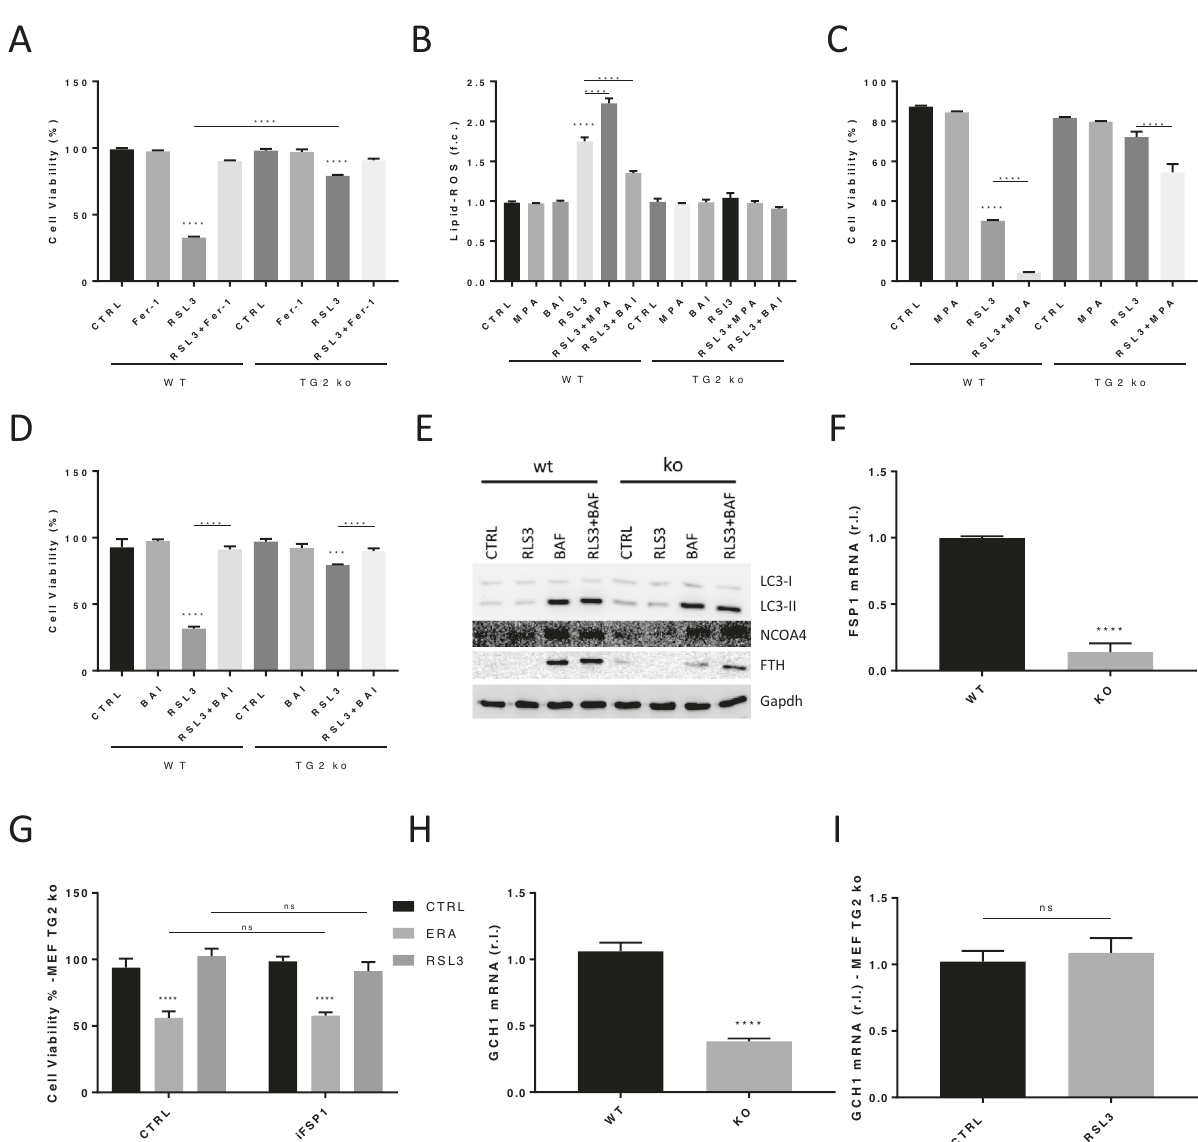
Fig. 1 TG2 ko MEFs are resistant to Ferroptosis. A MEF wt and TG2 ko were exposed to 20 nM RSL3 alone or in combination with Fer-1 (10 μ M) and cell viability was evaluated after 18 h, in cells stained with FDI/PI, by fl ow cytometry. B MEF wt and TG2 ko were treated as indicated and Lipid-ROS were evaluated after 8 h, by cyto fl uorimetric analysis of BODIPY C11 stained cells. C & D Cells were treated as indicated and cell viability was evaluated as in A. E MEF wt and TG2 ko were cultivated in complete medium ± BAF (5 nM) or exposed to RSL3 (20 nM) ± BAF and Autophagy was evaluated as LC3 conversion, while Ferritinophagy was evaluated by measuring the protein levels of FTH and NCOA4. F Basal expression of FSP1 was evaluated in wt and TG2 ko MEFs by qPCR. G Cell viability was evaluated as in B in TG2 ko MEF cells exposed 18 h to RSL3 (20 nM) alone or in combination with iFSP1 (6 μ M). H Basal expression of GCH1 was evaluated in both wt and TG2 ko MEFs by qPCR. I TG2 ko MEFs were treated or untreated with 20 nM RSL3 and GCH1 expression was evaluated after 8 h, by qPCR. Data are representative of three independent experiments performed in triplicate. Histograms represent mean ± s.d.; * p < 0.05; ** p < 0.01; *** p < 0.001; **** p < 0.0001; ns not statistically signi fi cant. Gapdh was used as loading control in IB reported in E.